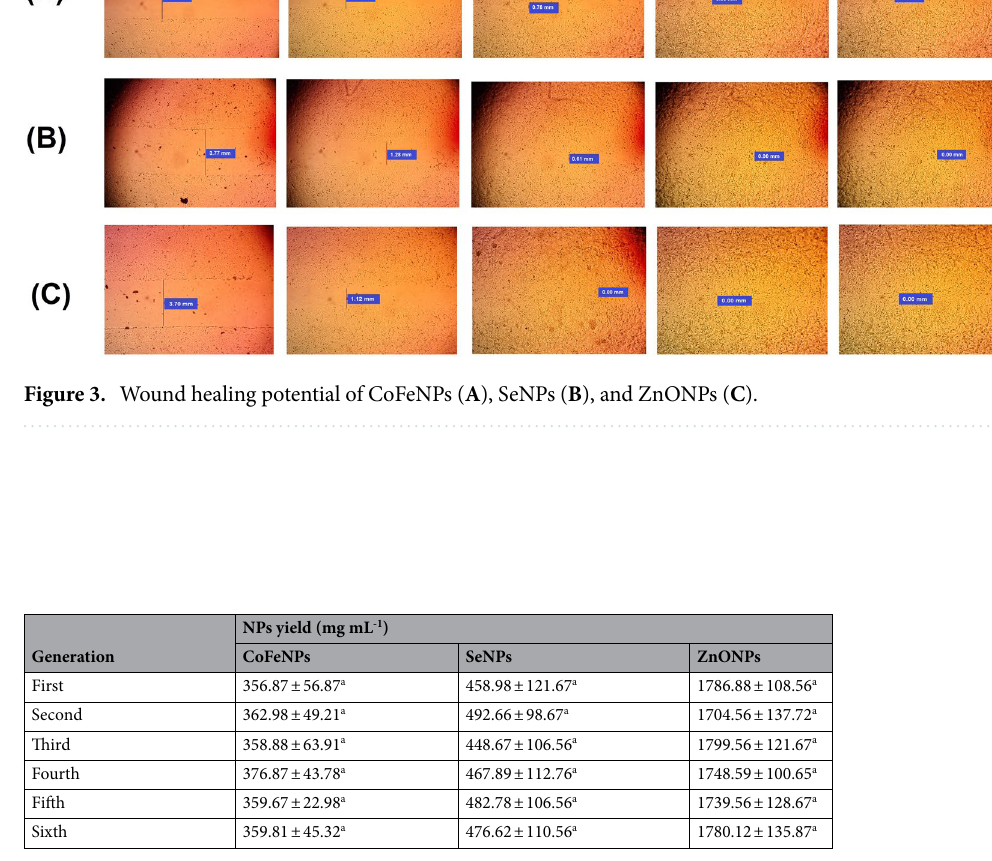
Table 2. NPs yield (mg L -1 culture filtrate) of CoFeNPs and SeNPs synthesized by M. purpureus Mutant-2022 and ZnONPs synthesized by A. tenuissima Mutant-1985 mutant strains grown for six successive generations. The calculated mean is for triplicate measurements from two independent experiments ± SD. a means with different superscripts in the same column are considered statistically different (LSD test, P ≤ 0.05